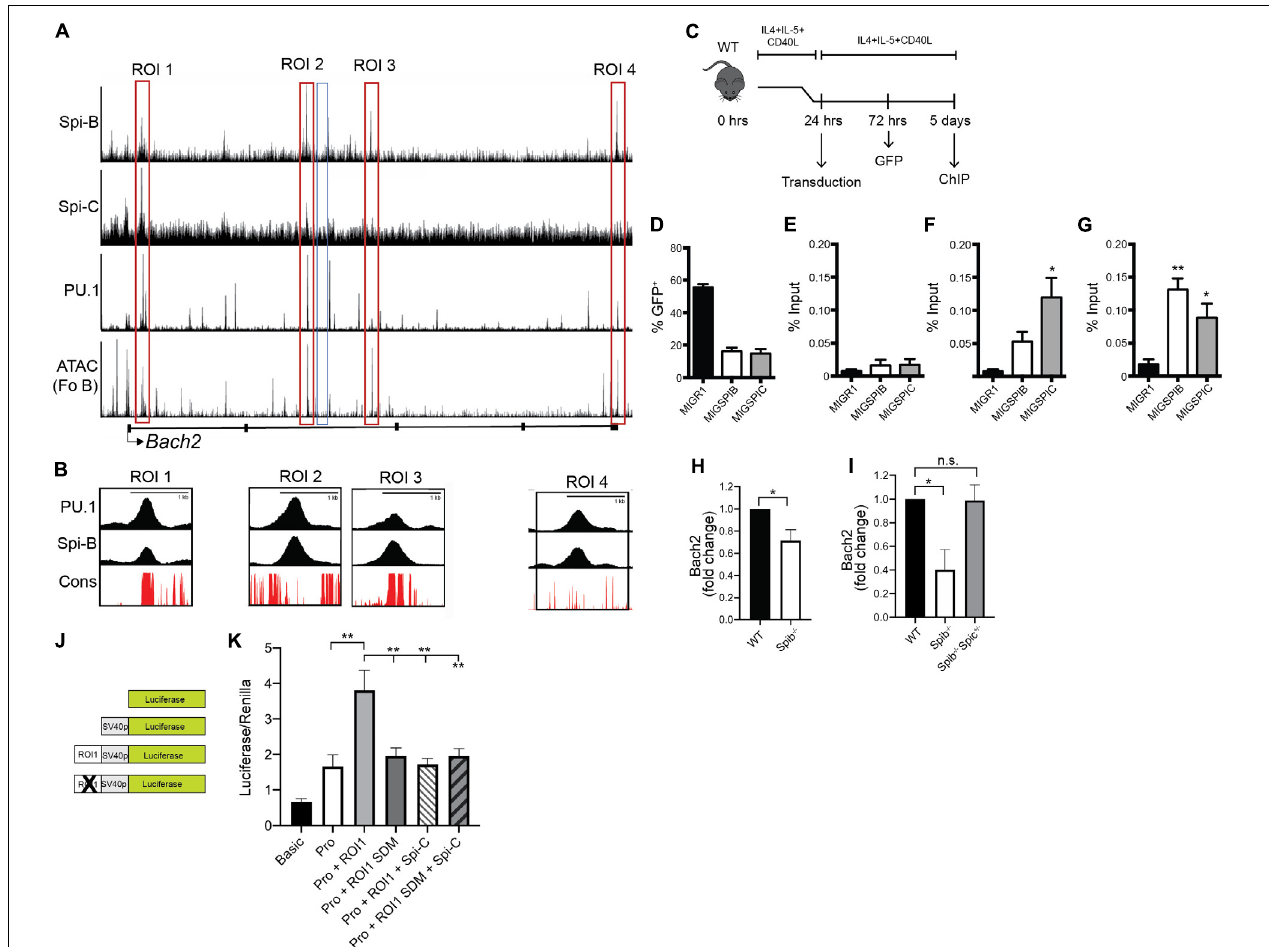
FIGURE 6 | Regulation of Bach2 by Spi-B and Spi-C. (A) UCSC genome browser tracks of ChIP-seq analysis of 3XFLAG-tagged Spi-B in WEHI-279 cells (top panel) and Spi-C in 38B9 cells (second panel). Also shown is ChIP-seq analysis of 3X-FLAG-tagged PU.1 binding in pro-B cells (third panel) and IMMGEN ATAC-seq analysis performed in enriched follicular B cells (Fo B) (Fourth panel). Bach2 gene structure is shown below, with black boxes denoting exons and lines representing introns. Red boxes indicate regions-of-interest (ROIs 1-4), while the blue box denotes the negative control region (NCR). (B) Multiple placental species conservation analysis (in red) visualized as superimposed UCSC tracks of ChIP-seq (ROI 1-4, in black) within the Bach2 locus for PU.1 and Spi-B. (C) Schematic depicting the workflow for primary B cell transduction, followed by chromatin immunoprecipitation (ChIP). (D) Frequency of GFP + cells, 48 h following transduction of WT enriched B cells with the indicated retroviral vectors. Bars represent the mean transduction efficiency ± SEM. (E–G) Enrichment of FLAG-tagged Spi-B and Spi-C in cultured WT B cells at the NCR (E) , ROI 1 (F) , and ROI 3 (G) . Results are shown as percentage of input DNA, with bars representing mean% input ± SEM ( n = 3 independent experiments using cells from individual mice, one-way ANOVA with Tukey’s multiple comparisons test), * p < 0.05; ** p < 0.01. (H) Reduced Bach2 mRNA transcript levels in Spib − / − B cells. RT-qPCR analysis was performed on RNA prepared from splenic B cells enriched from WT and Spib − / − mice ( n = 5 independent experiments using individual mice of each genotype, one sample t and Wilcoxon test), * p < 0.05. (I) Reduced Bach2 mRNA transcript levels in Spib − / − GC B cells. RT-qPCR analysis was performed on RNA prepared from splenic GC B cells enriched from WT, Spib − / − , and Spib − / − Spic + / − mice by cell sorting, 10 days after immunization with NP-KLH. Result is shown for representative experiment with triplicate technical replicates, Kruskal-Wallis with Dunn’s multiple comparisons test, * p < 0.05. (J) Schematic of luciferase reporters pGL3-basic (first panel), pGL3-promoter (second panel), pGL3-promoter-ROI 1 (third panel),